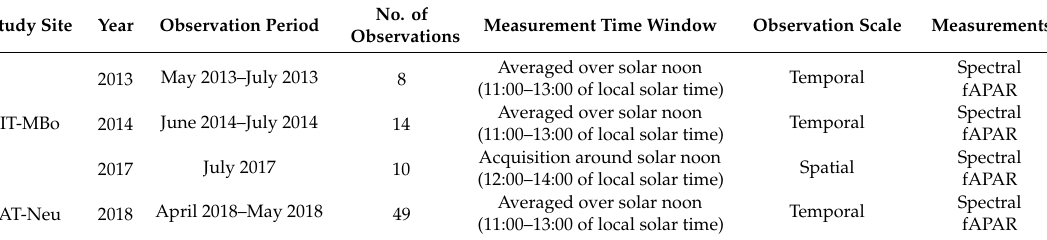
Table 1. Summary of spectral and biophysical measurements acquired in the